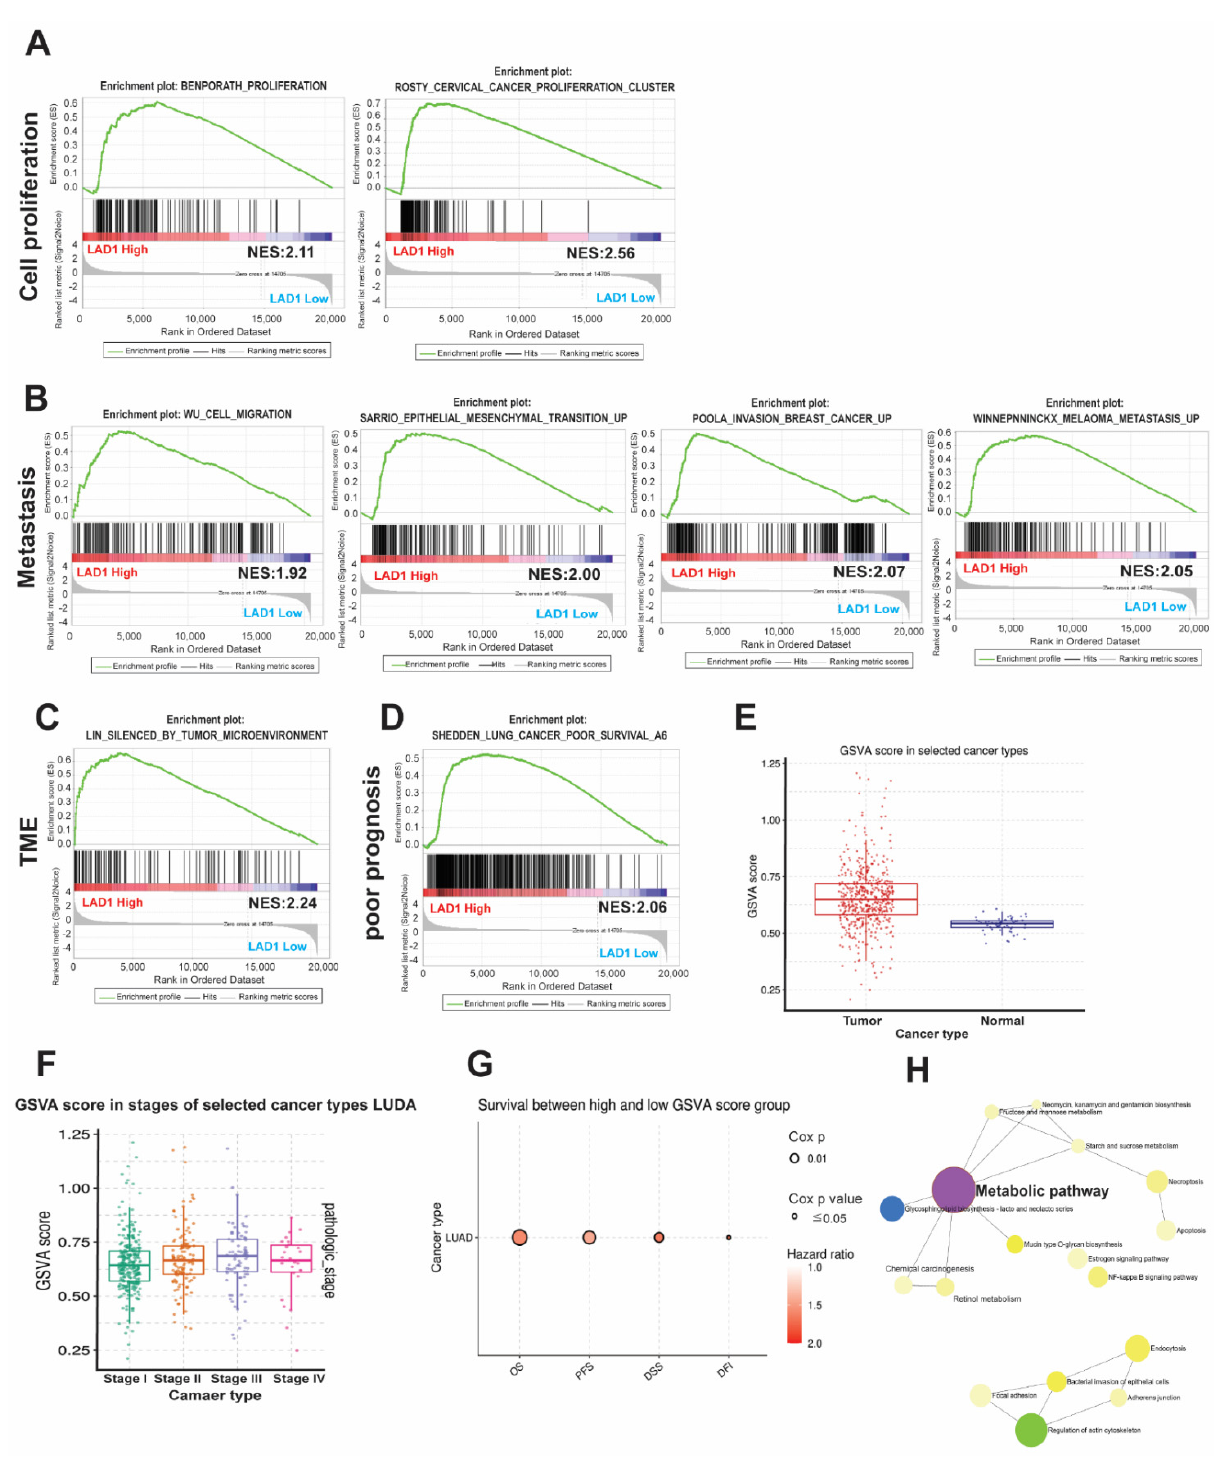
Figure 4. Functional status and pathway analysis of LAD1 in LUAD. ( A ) The association of cell proliferation, tumor metastasis ( B ), the tumor microenvironment ( C ), and poor prognosis ( D ) with LAD1 expression is analyzed by gene set enrichment analysis (GSEA). All these functional statuses are all enriched with high LAD1 expression. Meanwhile, gene set variation analysis (GSVA) scores were also used to analyze LAD1 expression difference between the tumor tissues and normal tissues ( E ), among the caner stages ( F ), and the survival analysis ( G ) from the TCGA datasets. ( H ) The pathways positively correlated with LAD1 according to correlated gene sets are illustrated. The metabolism pathway is significantly associated with LAD1 expression in LUAD.